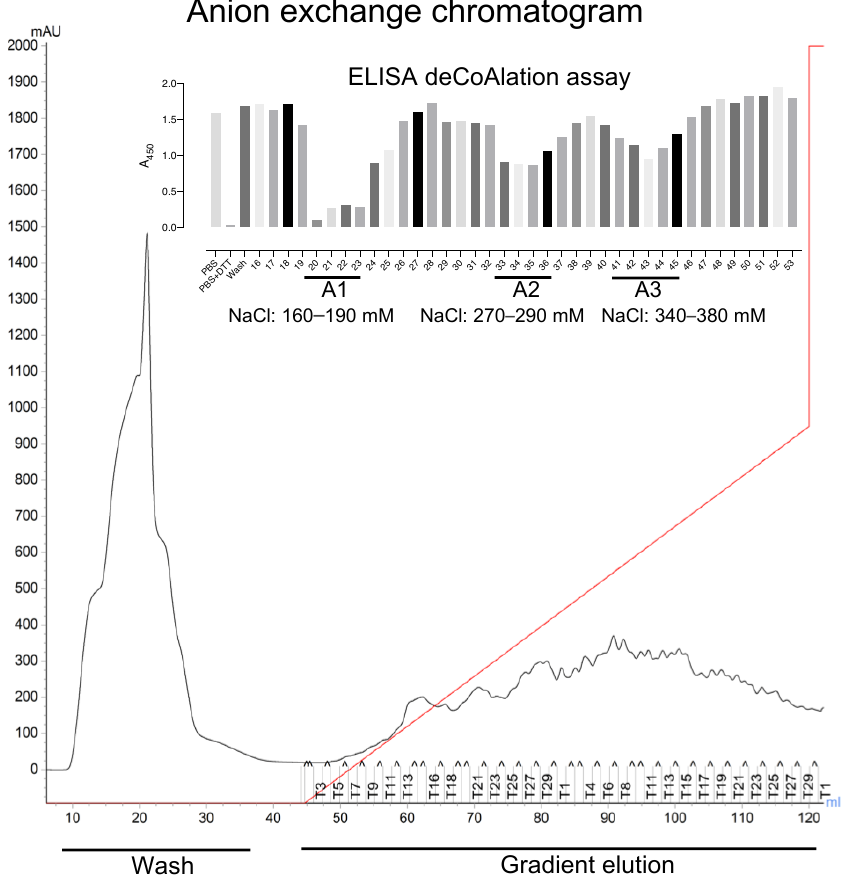
Figure 2. Three peaks of deCoAlation activities are observed from anion-exchange chromatography purification of B. megaterium lysate. The AEX chromatogram is shown. The B. megaterium lysate was applied to the column, and the unbound proteins were washed out of the column (Wash step). The bound proteins were eluted by using a NaCl gradient (red line) (Gradient elution). The absorbance (A 280nm ) of the bound and unbound proteins are indicated by a black line. The figure insert shows the ELISA-based deCoAlation assay bar graph, where three deCoAlation activities are observed (A1, A2, and A3). The concentration of NaCl for each fraction with deCoAlation activity is shown. The bar graph was generated by using GraphPad Prism8 (version